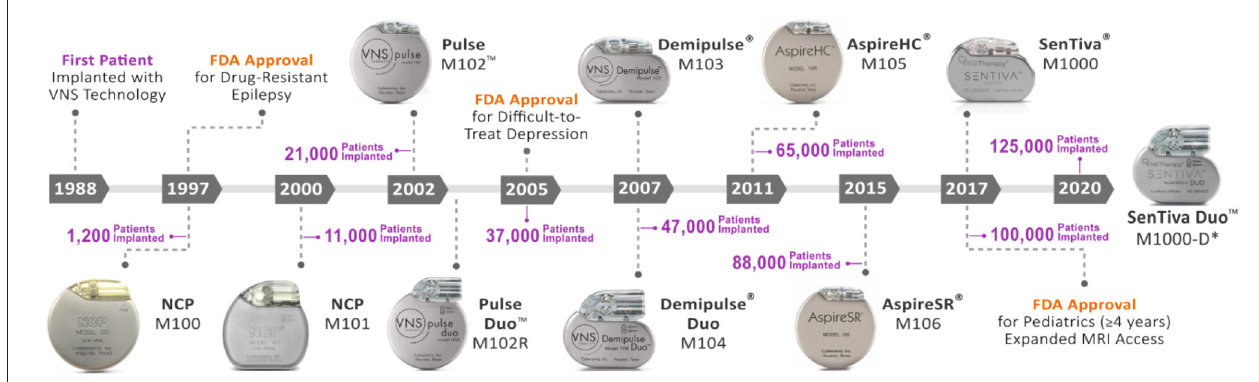
FIGURE 1 | Evolution of the VNS therapy system. Timeline of VNS Therapy System generators with respect to FDA release year and cumulative patient implants worldwide (LivaNova, data on file). In 1988, the first patient was implanted with the VNS Therapy technology by neurologist James Kiffin Penry and neurosurgeon William Bell at the Wake-Forest Bowman Gray School of Medicine in the United States (46). Since then, 10 iterations of the VNS Therapy technology have been released for commercial use. The number of total worldwide patient implants (purple) is shown with respect to generator release year. The VNS Therapy received FDA approval in 1997 for use as an adjunctive therapy in reducing the frequency of partial onset seizures which are refractory to anti-seizure medications in adults and adolescents over 12 years of age. The technology’s indication further expanded to include difficult-to-treat depression in 2005 and pediatrics ( ≥ 4 years) in 2017 (3). Expanded MRI access up to 3.0 Tesla imaging and allowing use of a transmit body coil for some generators also occurred in 2017 (5). *M1000-D generator is only licensed in Europe as of this review. HC, high capacity; M, model; MRI, magnetic resonance imaging; NCP, NeuroCybernetic Prosthesis; SR, sense and